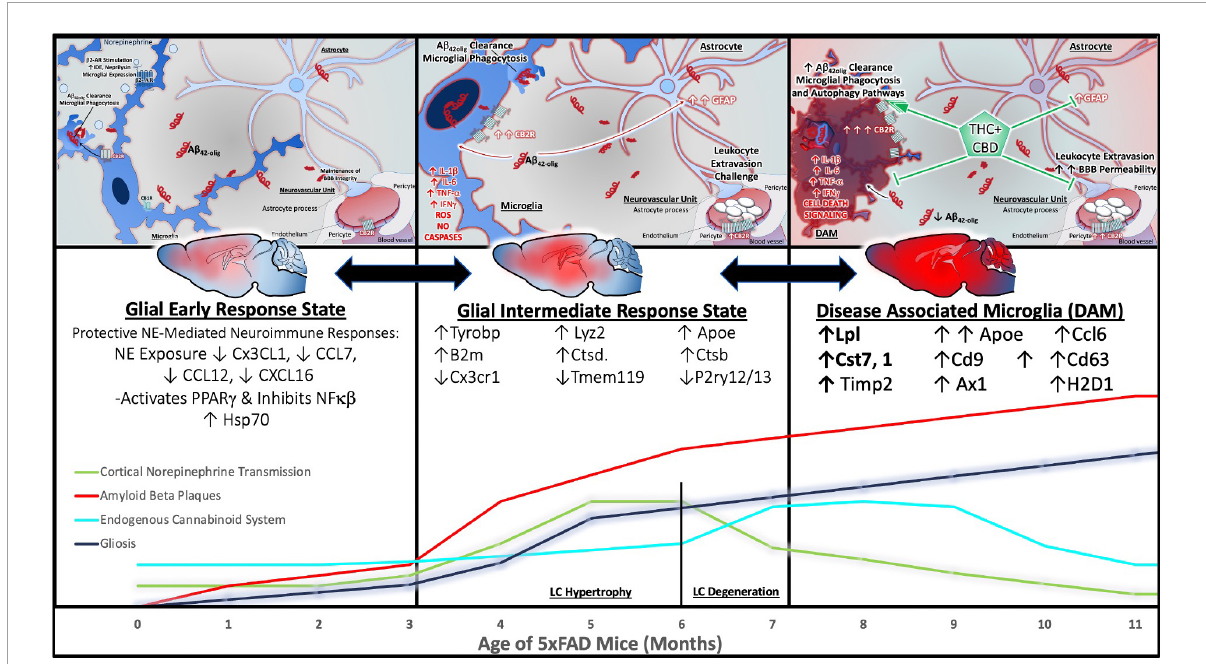
FIGURE7 Inflammatory progression in 5xFAD AD mouse model and beneficial effects of cannabinoids. The time course of neuropathology and inflammation in the 5xFAD model of AD LC-NE modulation of inflammation, LC degeneration, and the development of degeneration-associated microglial (DAM) phenotypes that have been defined by single-cell RNA polymerase experiments. 5xFAD mice develop cerebral amyloid plaques and gliosis by 2 months, exhibit reduced synaptic markers, neuronal loss and memory impairment by 4 months, and continue to accumulate extra- and intraneuronal A β 42 between 12 and 16 months of age. While intact, the LC-NE system is neuroprotective. NE mediates an increase in protein expression of the 70 kilodalton heat shock protein 70 (hsp70), and a reduction of nitric oxide synthase (NOS). By 3 months, 5xFAD mice show a significant increase in CB2r (Panel 1, left). By 5 months there is significant evidence of LC damage and inflammation. At 6 months, studies have demonstrated a shift in microglia phenotype from a homeostatic or early response state to an intermediate response state, and this transition is defined by the upregulation of AD-associated genes (B2m,Ctsd,Ctsb, Fth1, Tyrobp and apoe) and concurrent downregulation of the homeostatic CxCL1, P2ry12/P2ry13, and Tmem119 genes (Panel 2, center). 5xFAD mice show intrinsically decreased CB1r, decreased MAGL, increased DAGL and increased CB2r expression at 11 months. Studies evaluating microglial phenotypes in 5xFAD mice at 8 months show a distinct, TREM-2 dependent transition to the late response state known as DAM. The DAM phenotype is characterized by an increase in AD associated genes such as Lpl, apoe, and the TREM2-Tyrobp signaling complex. Importantly, a recent study demonstrates that in the 5xFAD model, CBD could improve the behavioral and cognitive function of AD mice by modulating the expression of IL-5 (Khodadadi et al., 2021). Other mechanisms of CBD + THC mediated protection include the reduction of inflammatory cytokines, promoting autophagy and microglial phagocytosis of amyloid plaques and maintaining blood brain barrier integrity by preventing leukocyte extravasion (Panel 3,